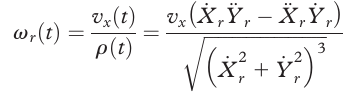
ffiffiffiffiffiffiffiffiffiffiffiffiffiffiffiffiffiffiffiffiffiffiffiffiffiffiffiffiffiffiffi p m 2 g 2 (cid:3) 0 : 25 g 2